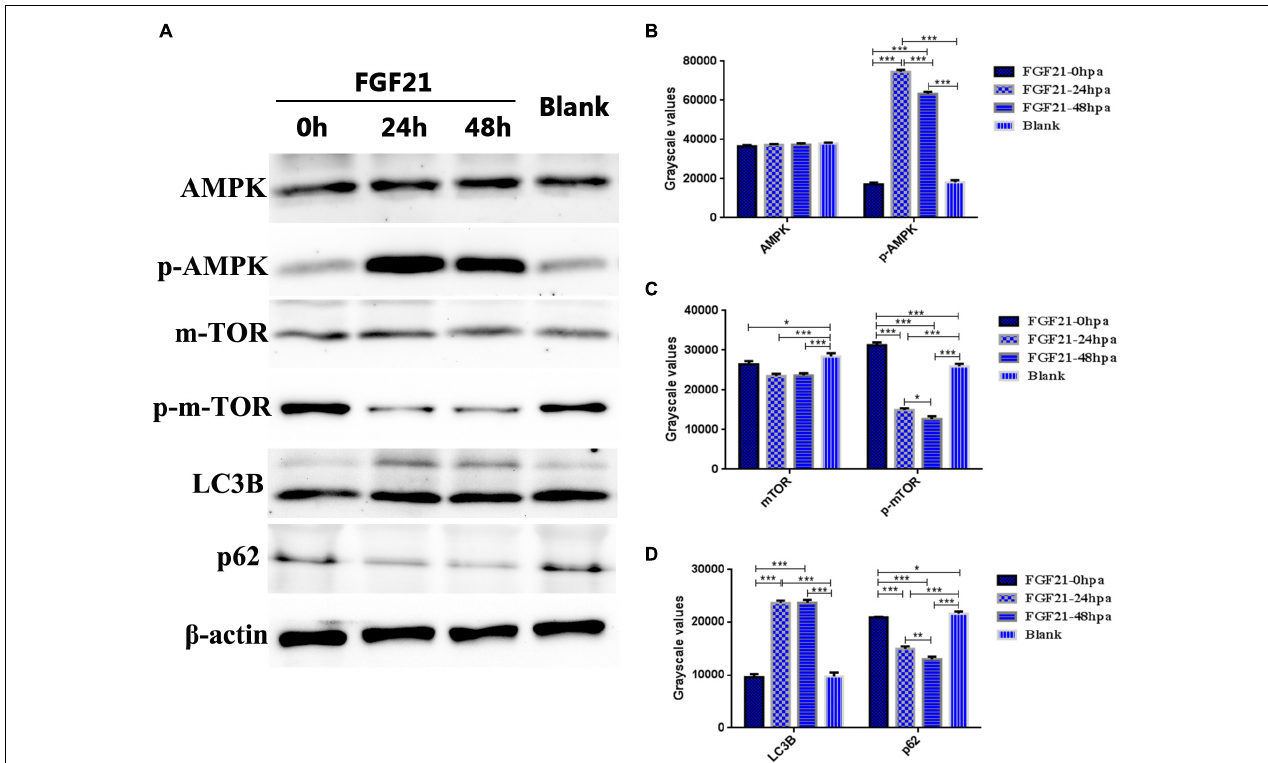
FIGURE 6 | Fibroblast growth factor 21 up-regulates autophagy through AMPK-mTOR signaling pathway. Samples were collected from three groups at 0, 24, and 48 hpa. (A) Western blotting showing levels of AMPK, p-AMPK, mTOR, p-mTOR, LC3B, and P62, corrected for β -actin as internal control. (B) Quantification of immunohybridization signal of AMPK and p -AMPK by grayscale values. (C) Quantification of immunohybridization signal of mTOR and p -mTOR by grayscale values. (D) Quantification of immunohybridization signal of LC3B and P62 by grayscale values. DMSO group: without Mtz treatment, DMSO was applied. Mtz group: after Mtz treatment, grow naturally. Mtz+FGF21 group: after Mtz treatment, treated with FGF21 standard protein. Significance: * p < 0.05, ** p < 0.01, and *** p < 0.001 vs. DMSO group. Data are expressed as mean ± SEM ( n = 40 per group, repeat 3 times for each